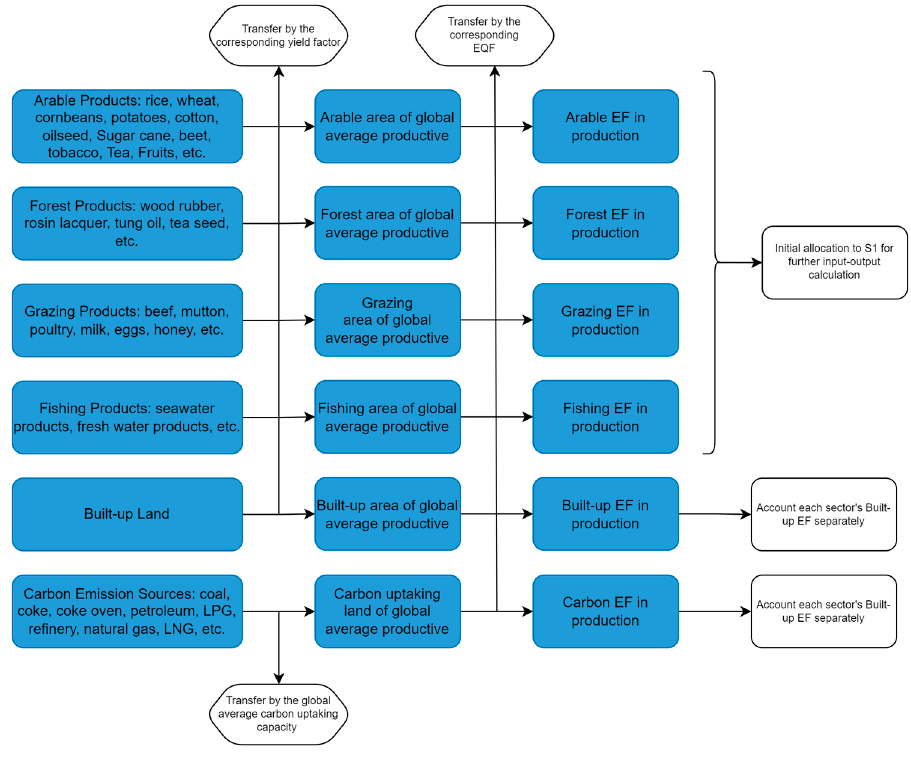
Figure 1. The diagram of EF accounting in